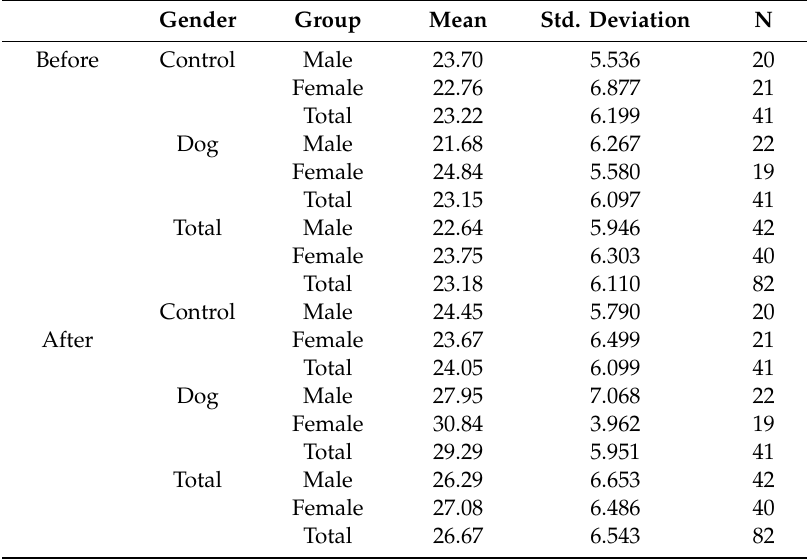
Table 10. Descriptive Statistics: Joviality and Gender. Gender Group Mean Std.